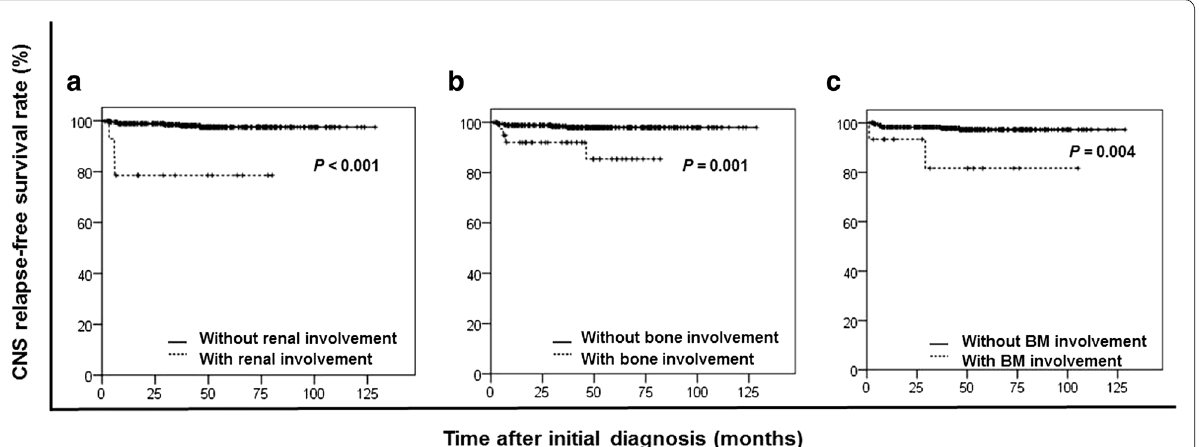
Fig. 3 Kaplan–Meier analysis estimated CNS relapse‑free survival for the 376 patients in the R‑CHOP (rituximab, cyclophosphamide, doxorubicin, vincristine, and prednisone) set stratified by independent risk factors. Renal involvement ( a ), bone involvement ( b ), and bone marrow (BM) involve‑ ment ( c ) were associated with short CNS relapse‑free survival